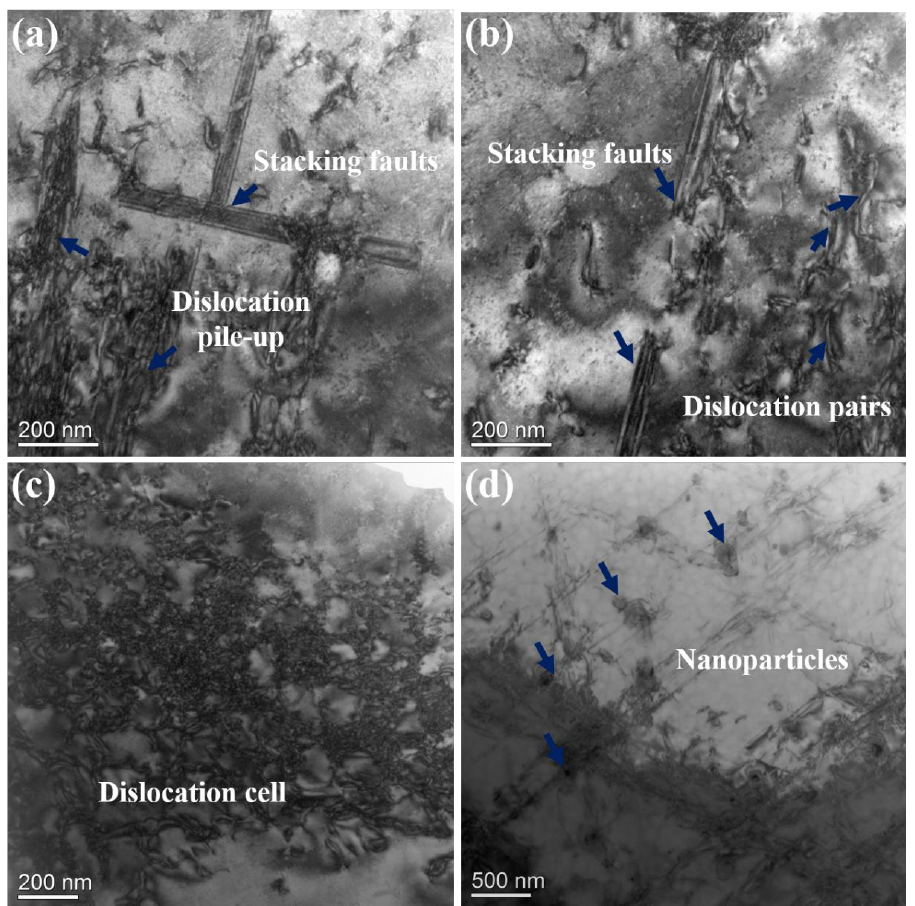
Figure 14. Deformed microstructure in the fractured specimen of 13Co: ( a ) stacking faults and dislocation pile-up; ( b ) stacking faults that sheared precipitates and interacted with dislocations; ( c ) dislocation cells; ( d ) nanoparticle-pinned